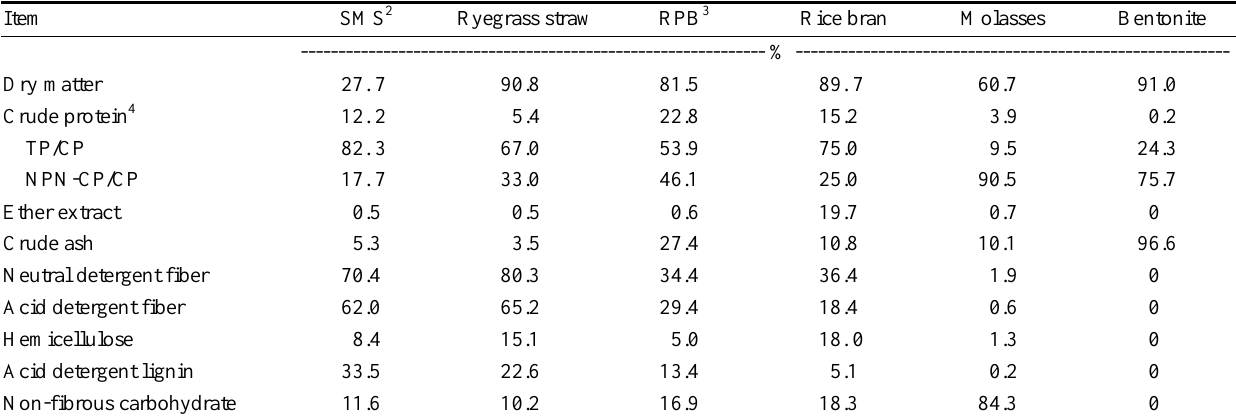
Table 1. The chemical composition of feed ingredients